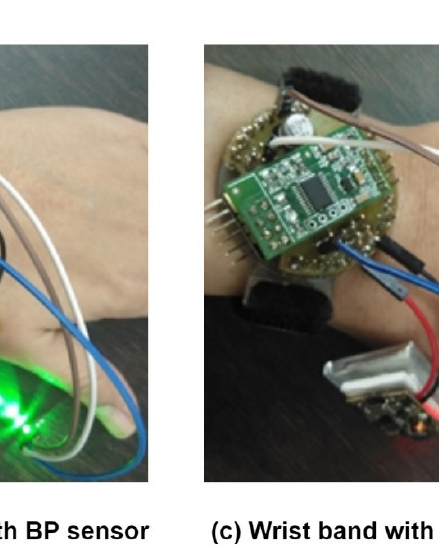
Figure 5. Block diagram of the wrist band.